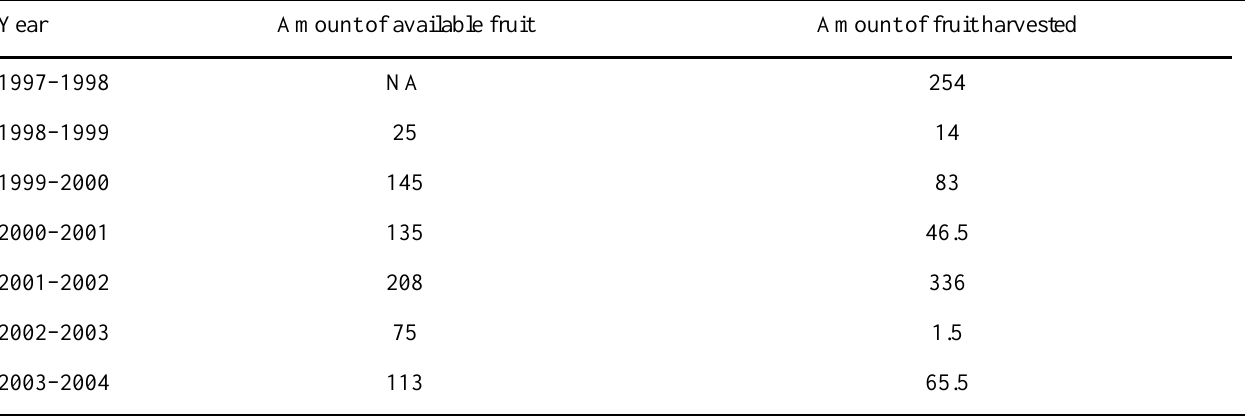
Table 1 . Estimates of fruit production and extraction for an 11,000-ha area in the Yelandur range of the Biligiri Rangaswamy Temple Wildlife Sanctuary. Values represent tons of amla ( Phyllanthus emblica and P. indofishceri ) fruit. The amount of available fruit was estimated by the visual estimation method as one of the participatory resource management activities. The amount of fruit harvested was estimated from records kept by the Large-Scale Adivasi Multi-Purpose